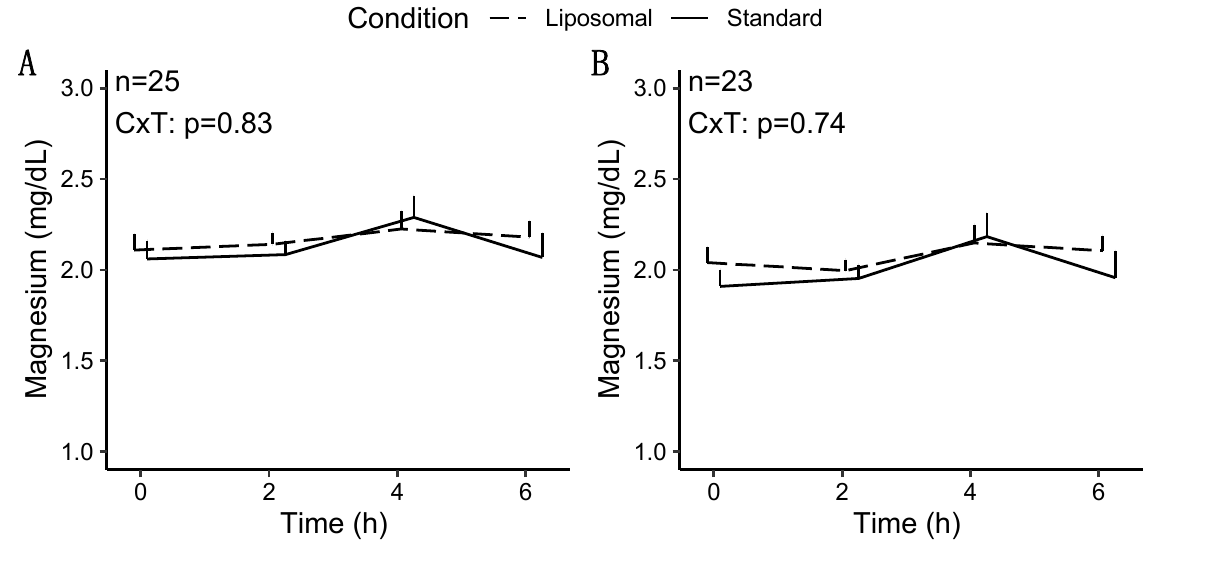
= 0.14 to p = 0.93). In contrast, within the standard MVM condition, the sole significant difference from baseline values was that the final observed value (6 h after MVM ingestion) fell below baseline values ( p = 0.001), unlike in the liposomal condition ( p = 0.93). Due to variation in raw baseline con- centrations between conditions, the raw changes presented above are viewed as supplemental/sec- ondary, while changes from the baseline and pharmacokinetic parameters (i.e., iAUC) were the pri- mary outcomes. “*” indicate statistical significance (i.e., p < 0.05).